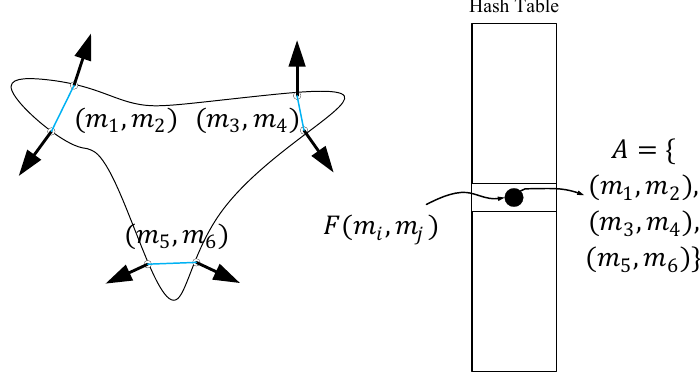
Figure 4. Model point pairs with similar